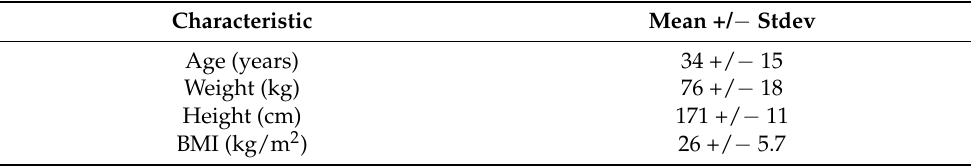
Table 1. Participant demographics (40 total, 17 male). BMI: body mass